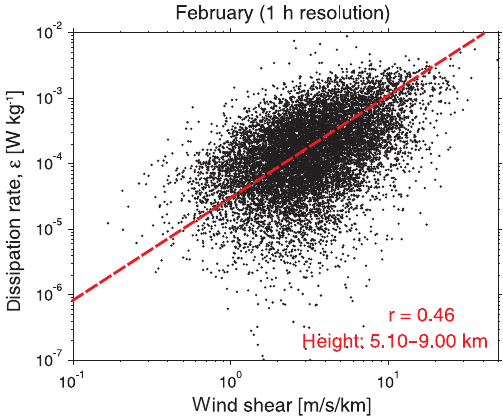
Figure 15. Scatter plot of the turbulent energy dissipation rates ε vs. the vertical shears of horizontal wind derived from the radar mea- surements with MAARSY in logarithmic scales. The values were derived based on all the data with 5min resolution in February in the years 2010–2013 at an altitude of 5.1km. The dashed line indi- cates an expected linear correlation between the two shown quanti- ties. The corresponding correlation coefficient r is indicated in the lower right corner, which is highly significant, i.e. well above the 99.9% level.